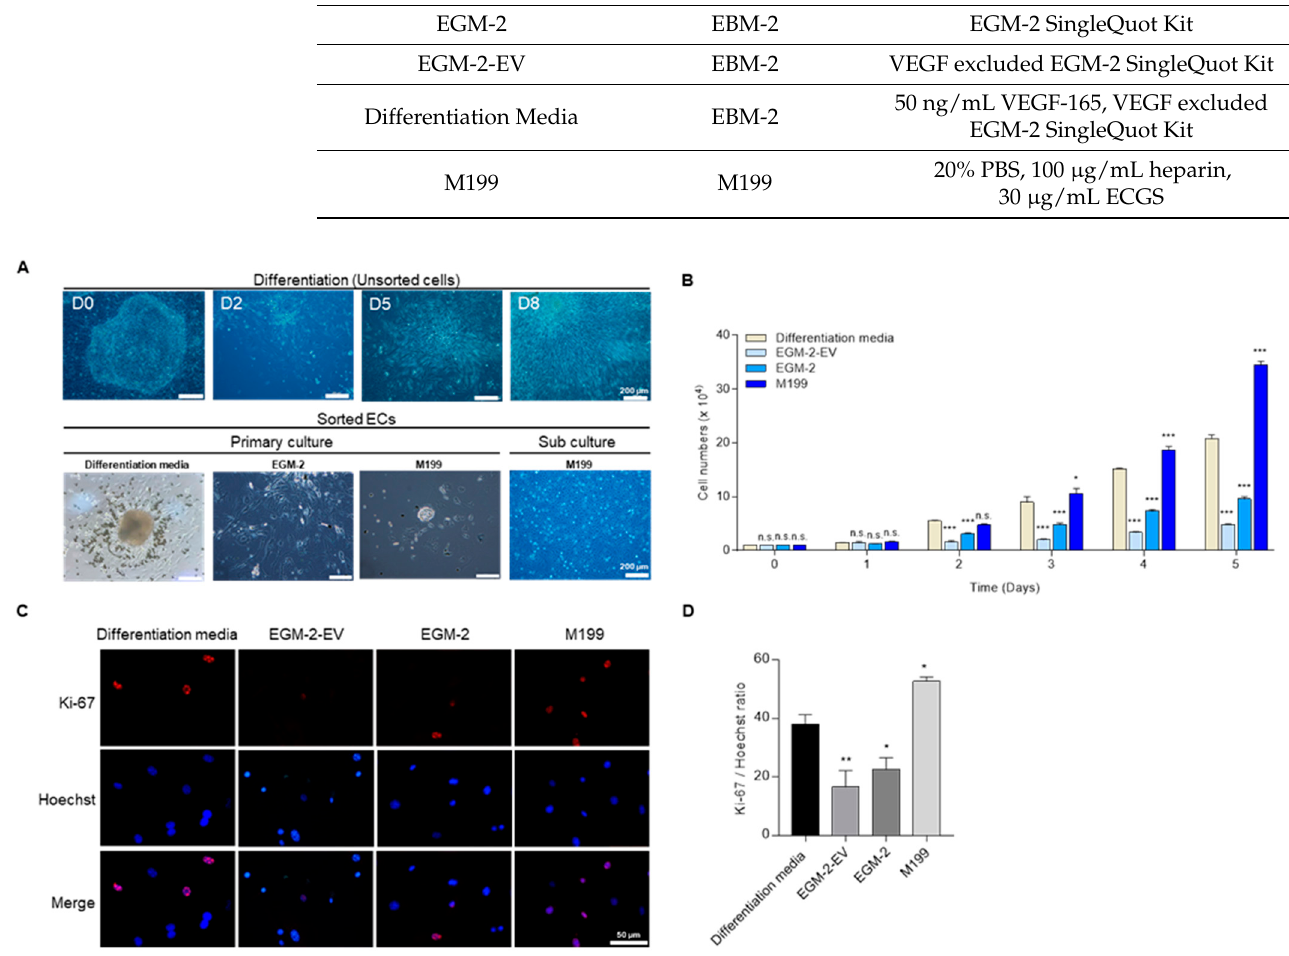
Table 2. Culture conditions for endothelial cells differentiated from porcine epiblast stem cells.